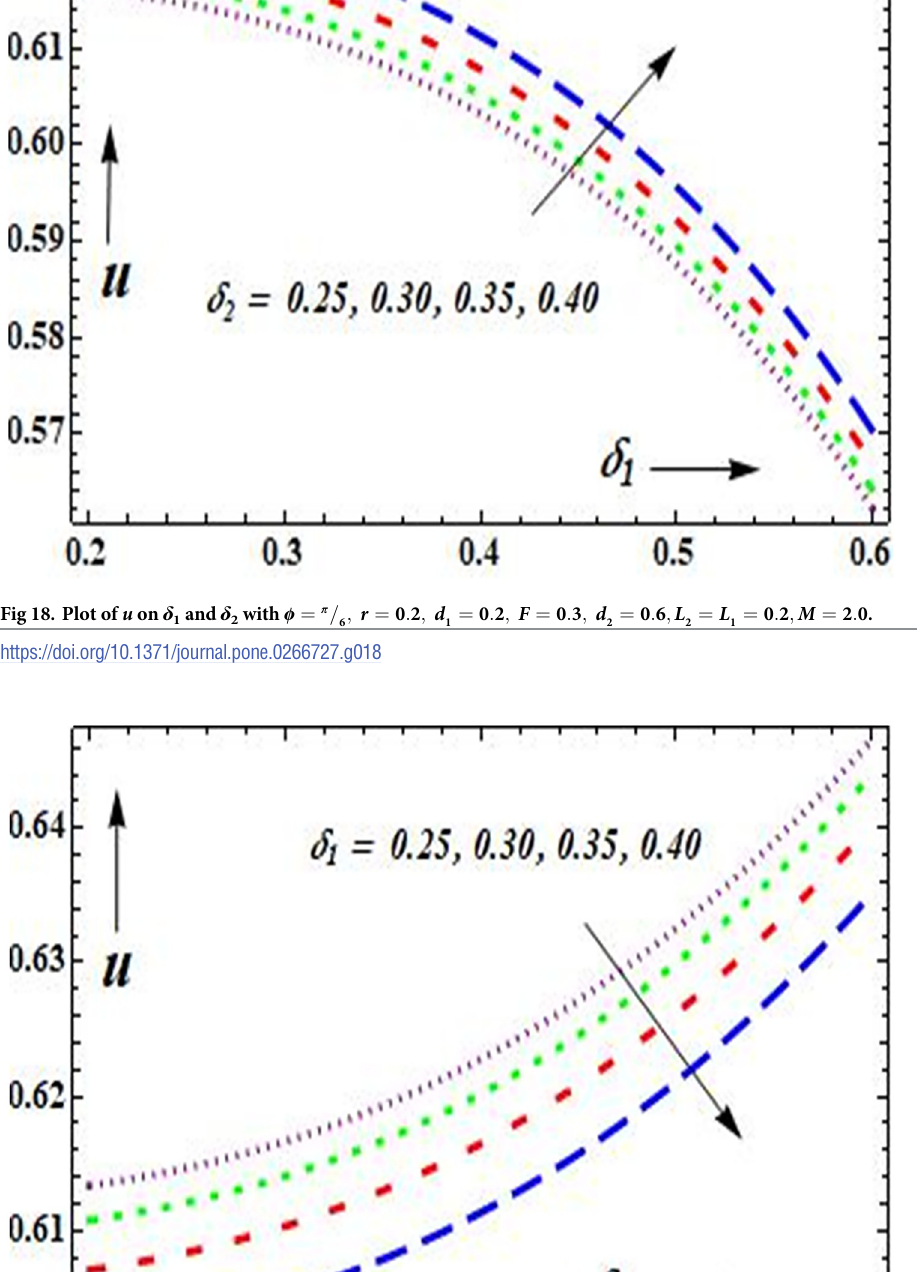
; r ¼ 0 : 2 ; d ¼ 0 : 2 ; F ¼ 0 : 3 ; d 6 1